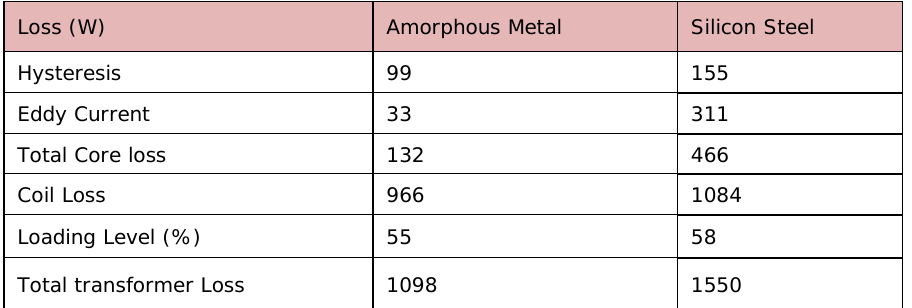
Table 3. “Comparison of loss of amorphous versus conventional cores”. Source: Targosz, & Topalis